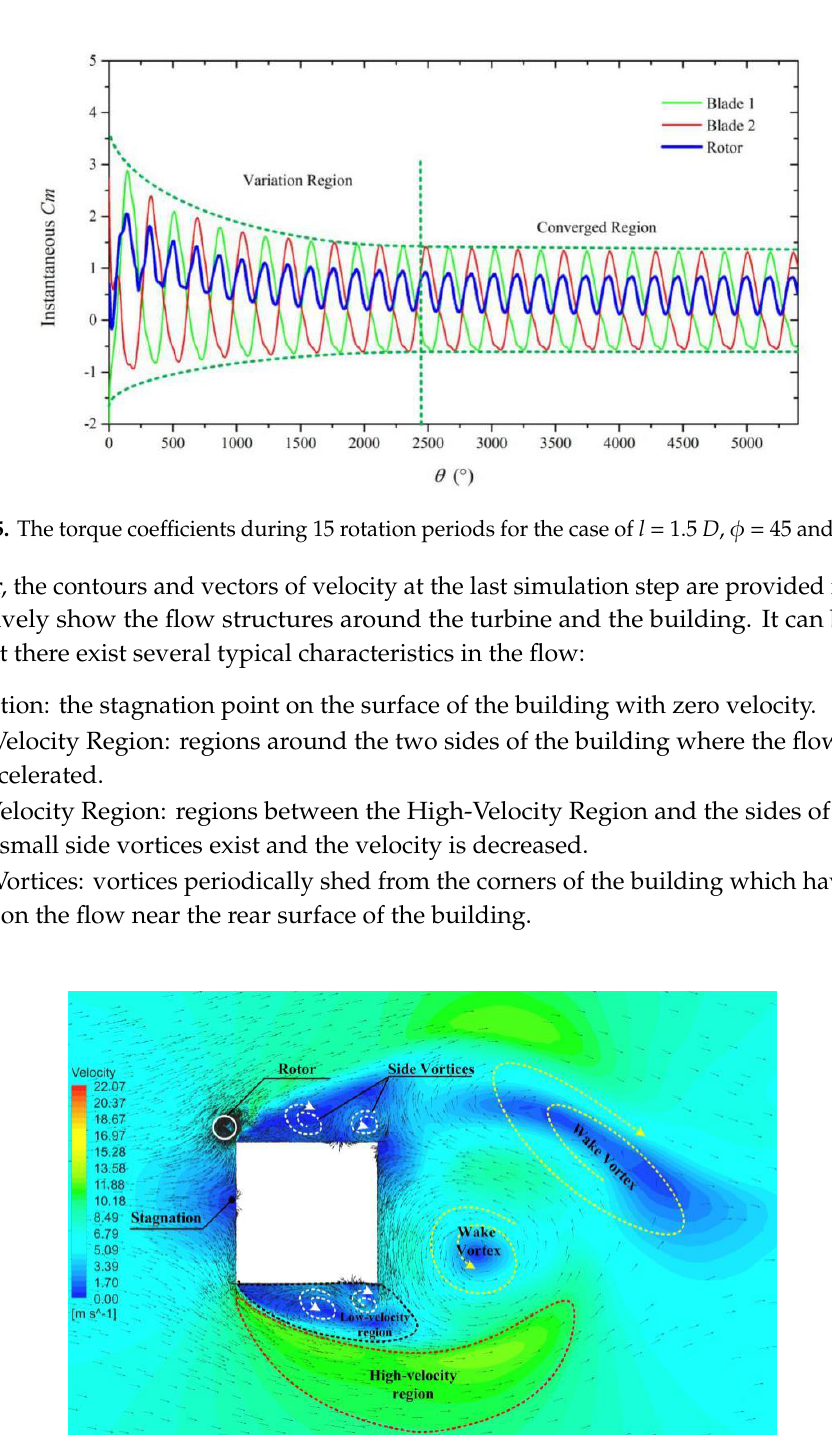
Figure 6. Contours and vectors of velocity around the building for the case of l = 1.5 D , φ = 45 ° and TSR = 1.